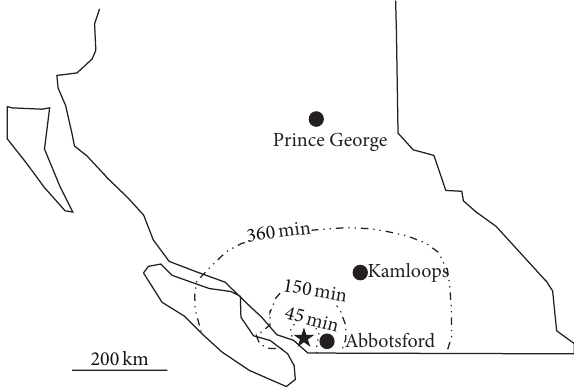
Figure 1: One-way travel time by automobile isochrones to St. Paul’s Hospital in Vancouver (star) along major roadways. Points on the map where major routes do not exist were interpolated. Satellite clinic locations are denoted by shaded